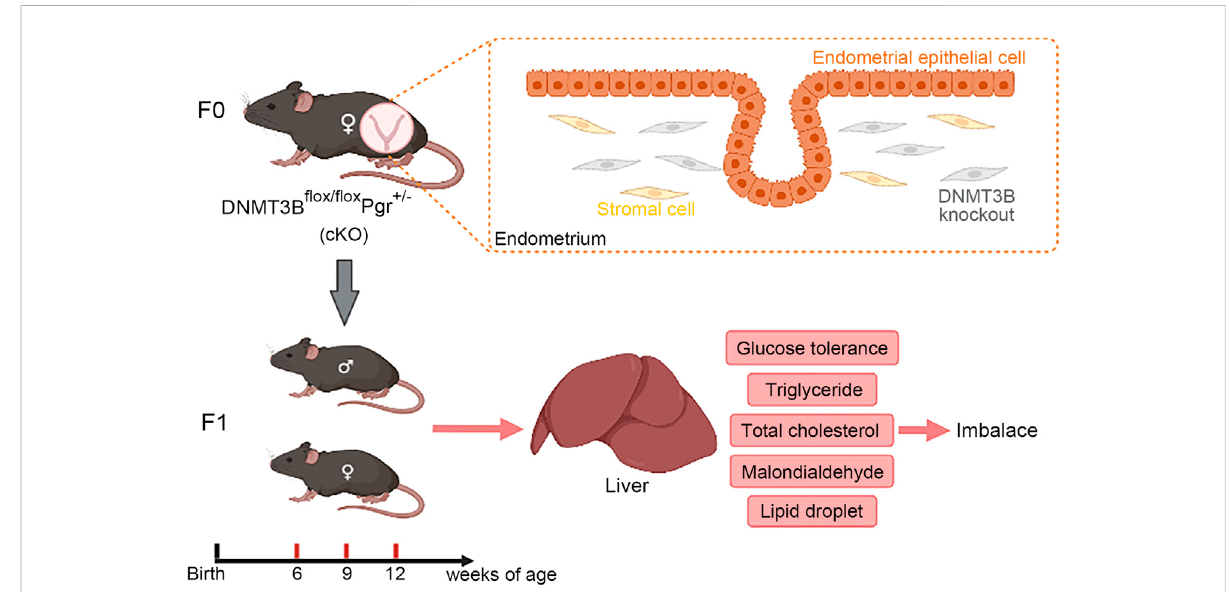
FIGURE 9 In this study, de novo methylation gene DNMT3B was conditionally knocked out from the endometrial stromal cells of maternal mice, which might cause changes in uterine environment and in fl uence health status of the next generation. Our results indicated that hepatic glucose and lipid metabolismwasabnormalincKOF1mice,mainlymanifestedasimpairedglucosetolerance,abnormalserumandliverlipidlevels,andincreasedlipid droplets deposition in the liver, suggesting that cKO F1 mice were at a greater risk of metabolic syndrome than control F1